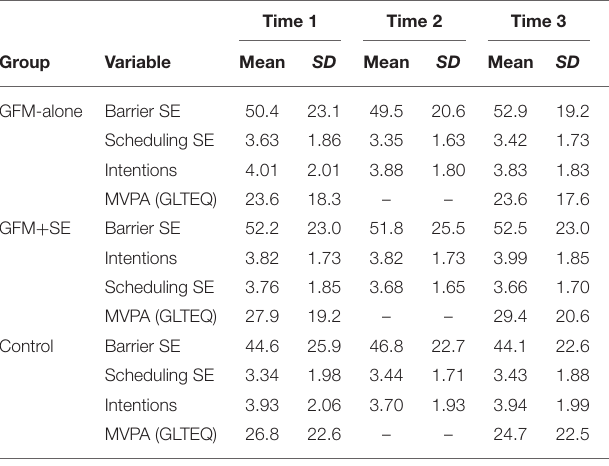
and Control groups were not different at T2 ( p = 0.14). TABLE 3 | Descriptive statistics for self-efficacy, intentions and MVPA variables at multiple time points. Time 1 Time 2 Time 3